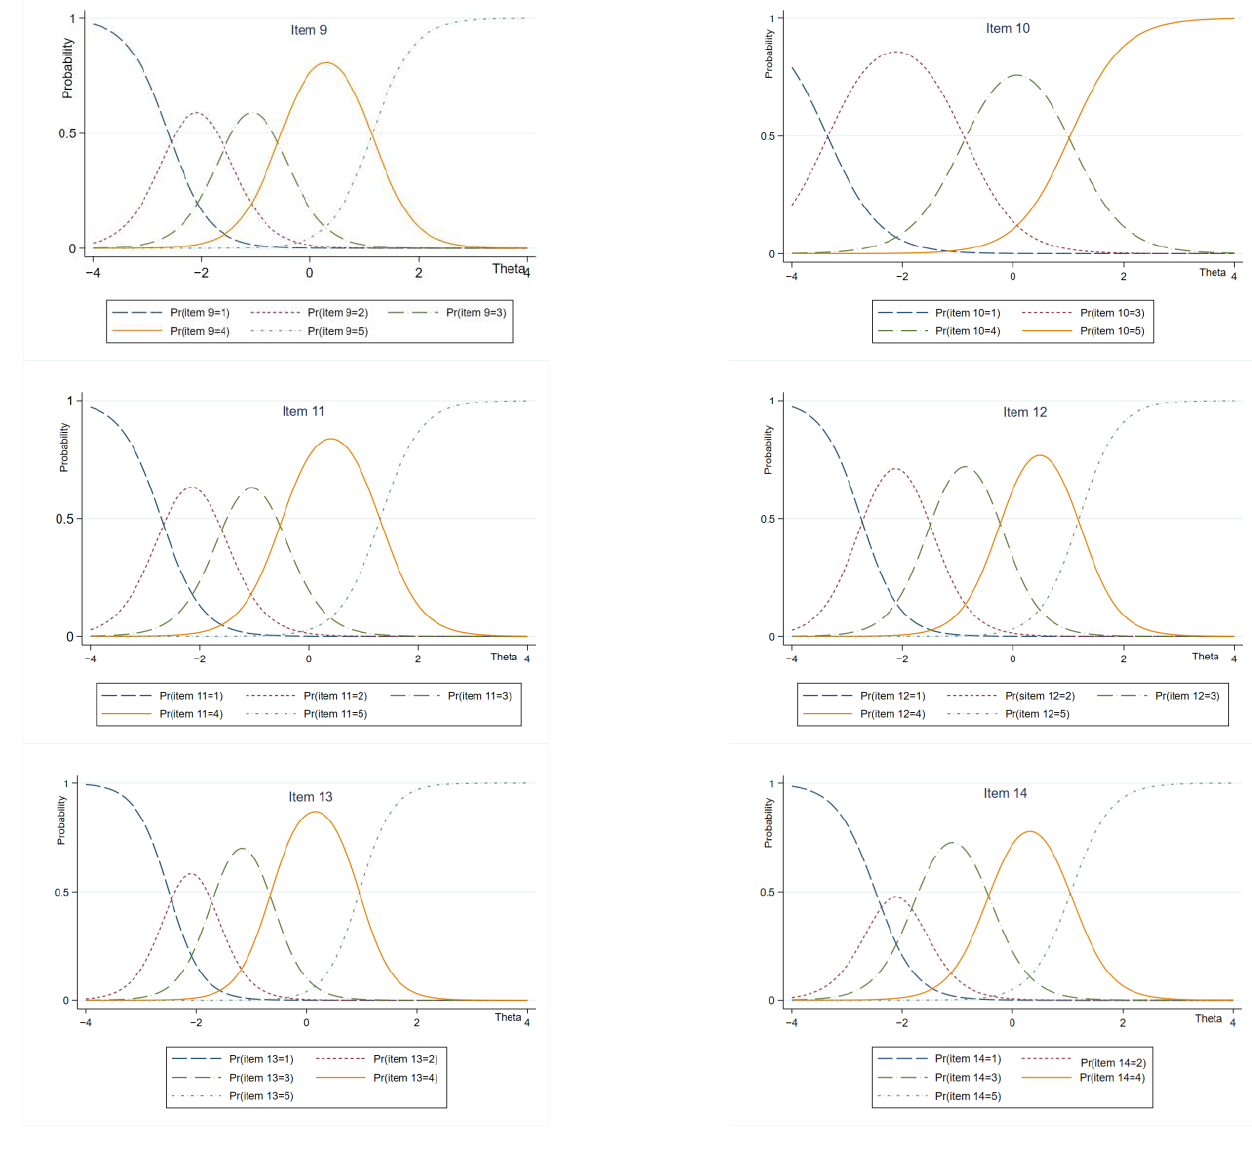
Figure 4. Item information function matrix.